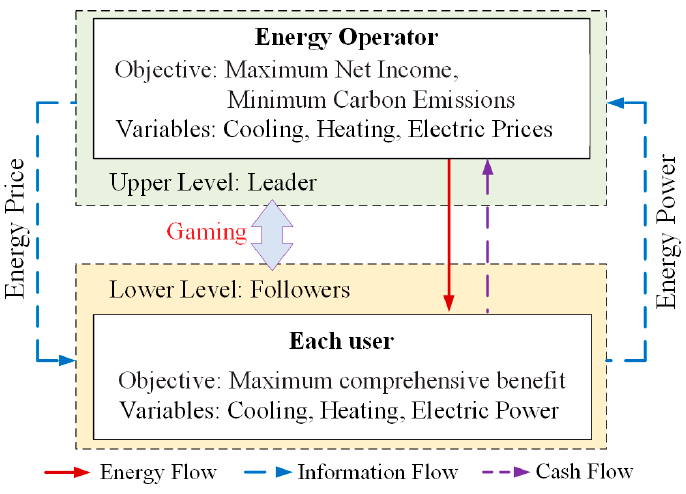
Figure 1. The relationship between operator and users.